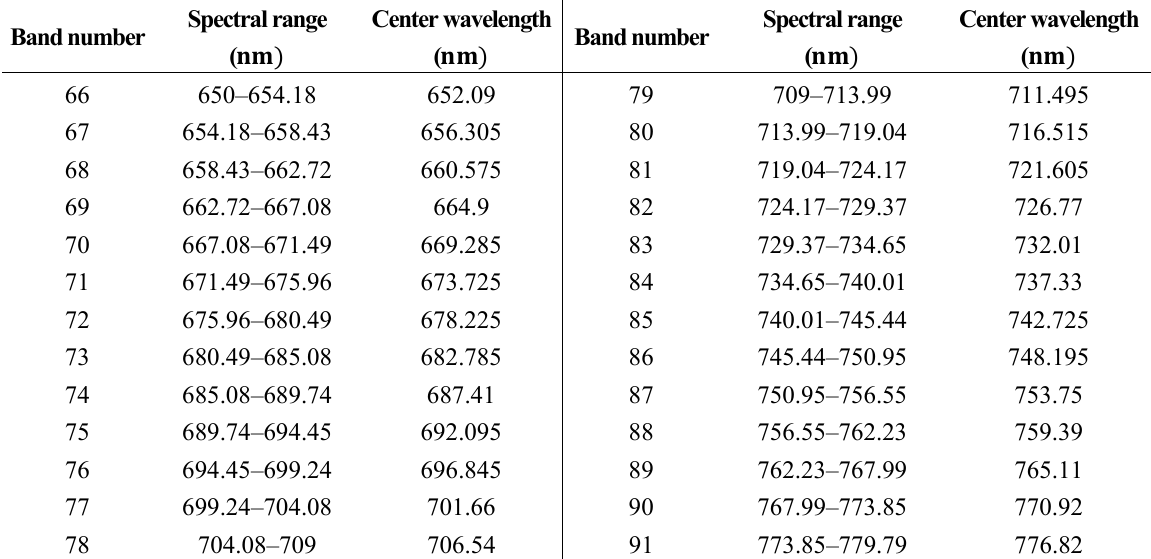
Table 1. Bands setting of HJ-1A